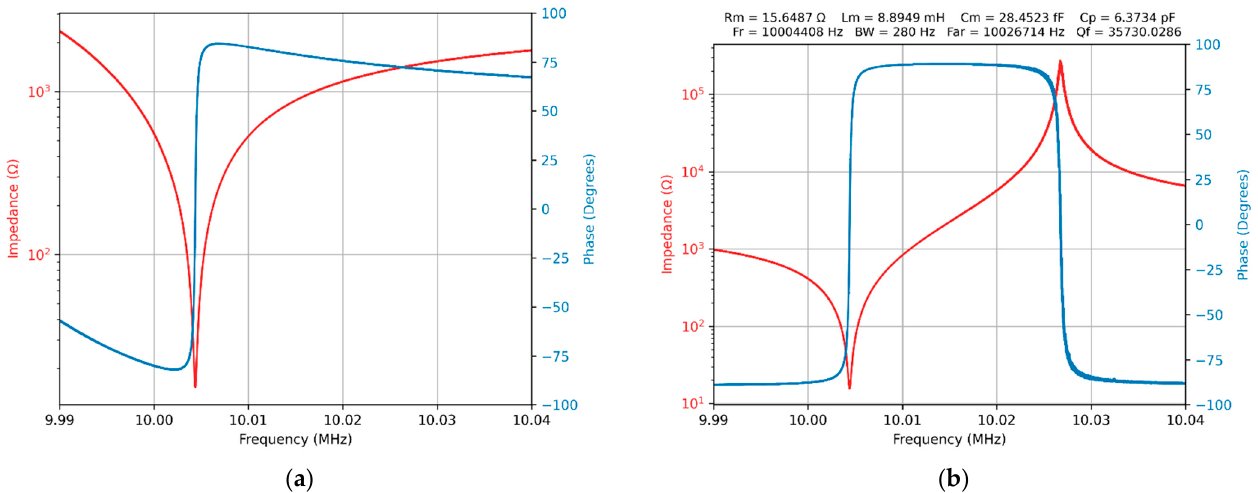
Figure 3. The virtual impedance analyzer (VIA): ( a ) QCM sensor in the air without compensation, ( b ) QCM sensor in the air with open- and short-circuit compensation.